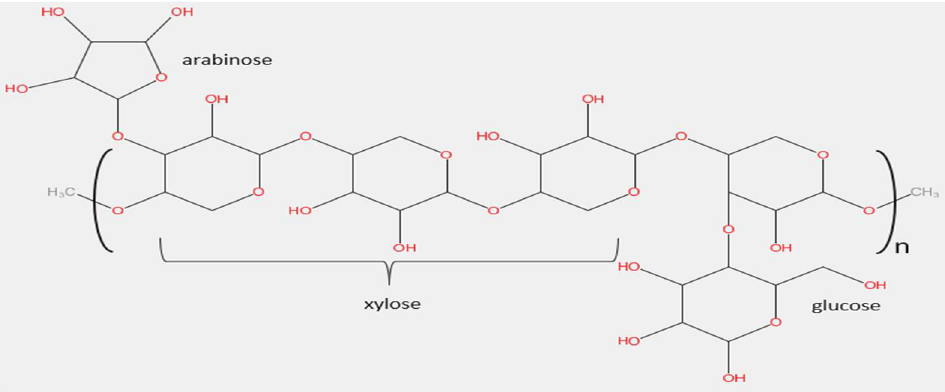
Figure 1. Simplified structure of bagasse.